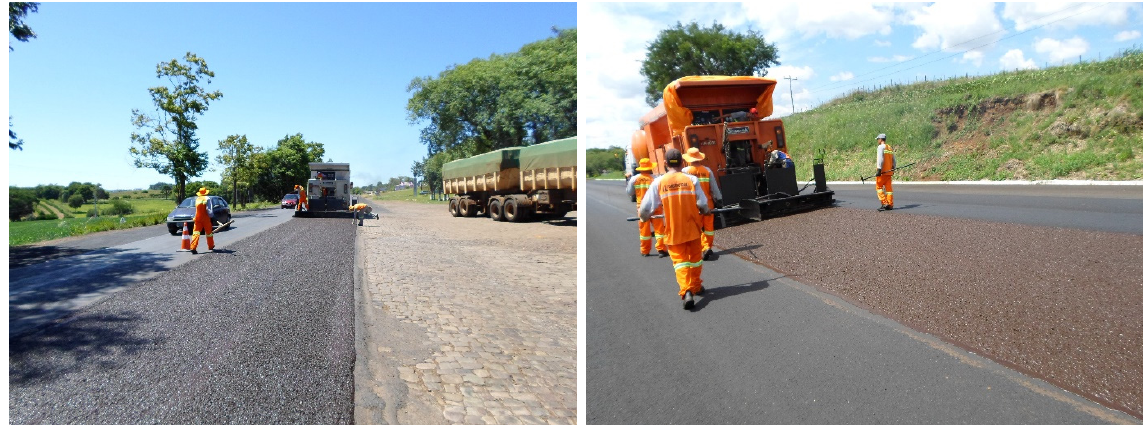
Figure 3. Example of an application of microsurfacing in Brazil. Table 3. Difference between slurry seal and micro surfacing from Brazilian experiences. Slurry